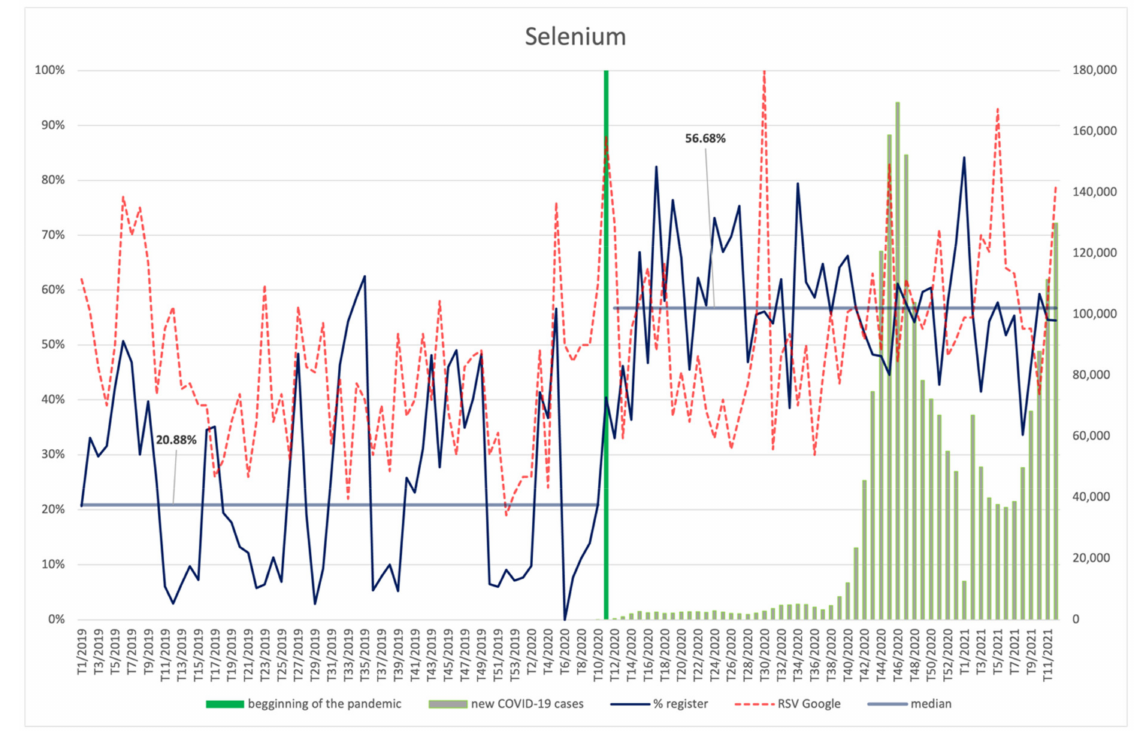
Figure 10. Comparison between the number of new registrations of products containing selenium, the number of COVID-19 cases, and the frequency of search for information on the ingredient in the Google